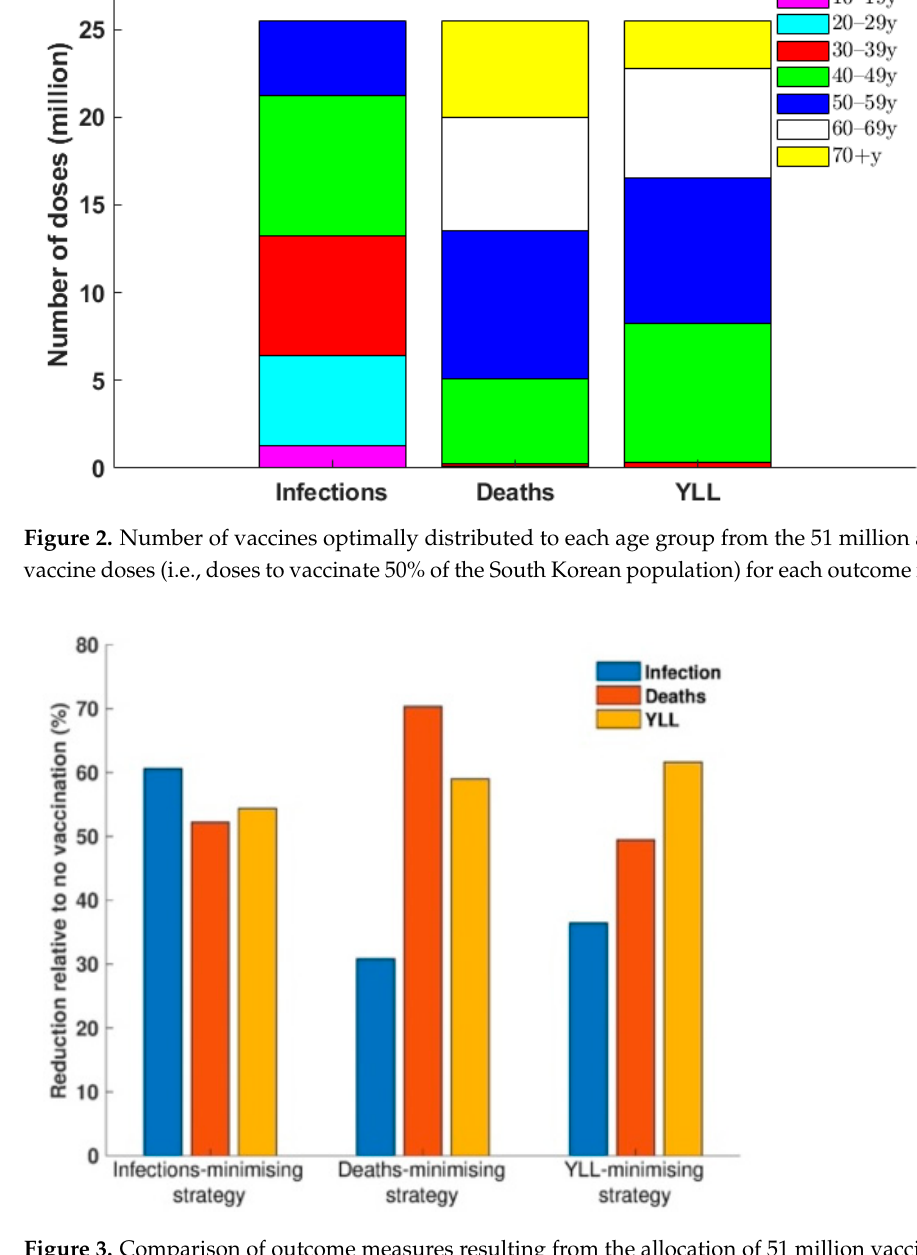
Figure 3. Comparison of outcome measures resulting from the allocation of 51 million vaccine doses for three different optimal vaccination strategies: to minimize the incidence, the number of deaths, and years of life lost (YLL).